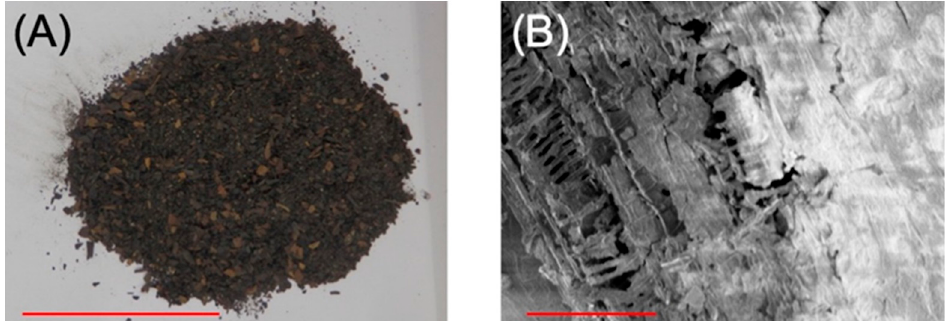
Figure 3. ( A ) Top view of the jatropha fallen leaf biochar that was produced by the carbonizer. Red scale bar represents 5 cm. ( B ) Close-up view of the surface of the jatropha fallen leaf biochar observed under an electron microscope. Red scale bar represents 100 μ m.